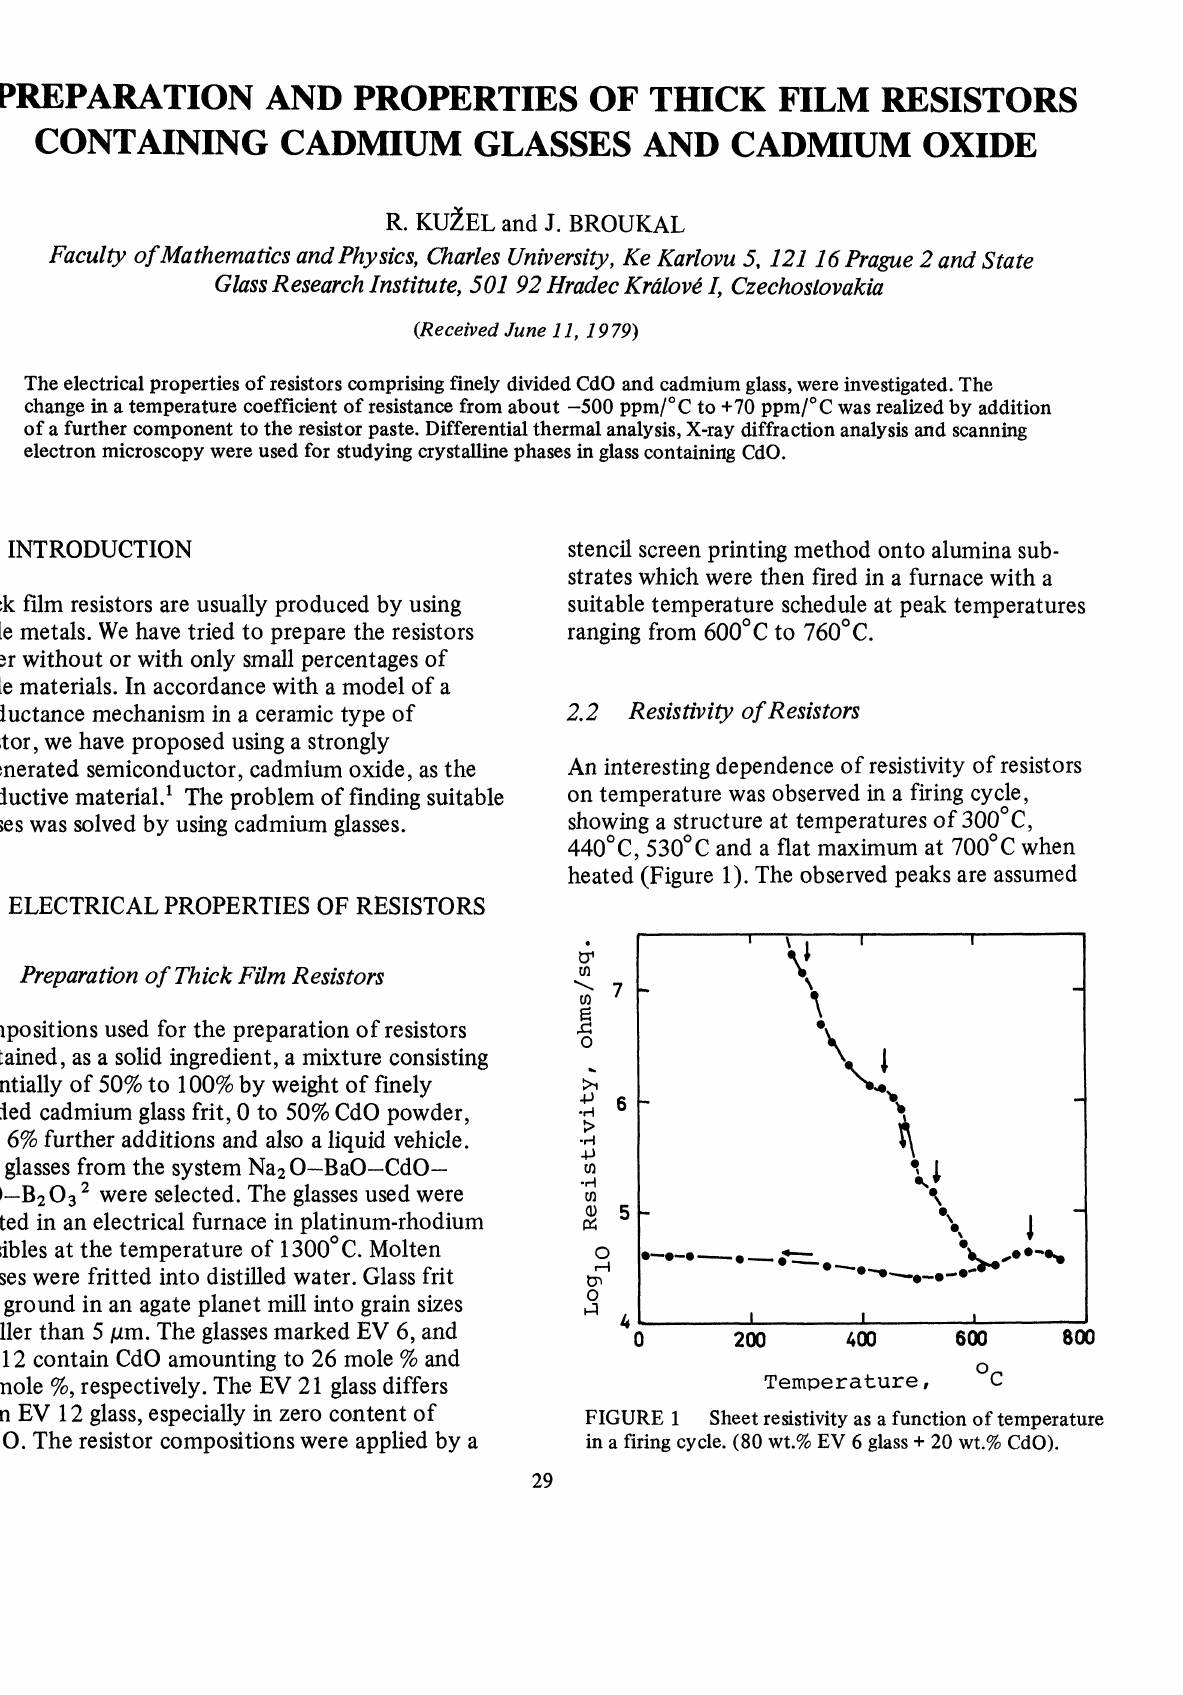
FIGURE Sheet resistivity as a function of temperature in a firing cycle. (80 wt.% EV 6 glass + 20 wt.%